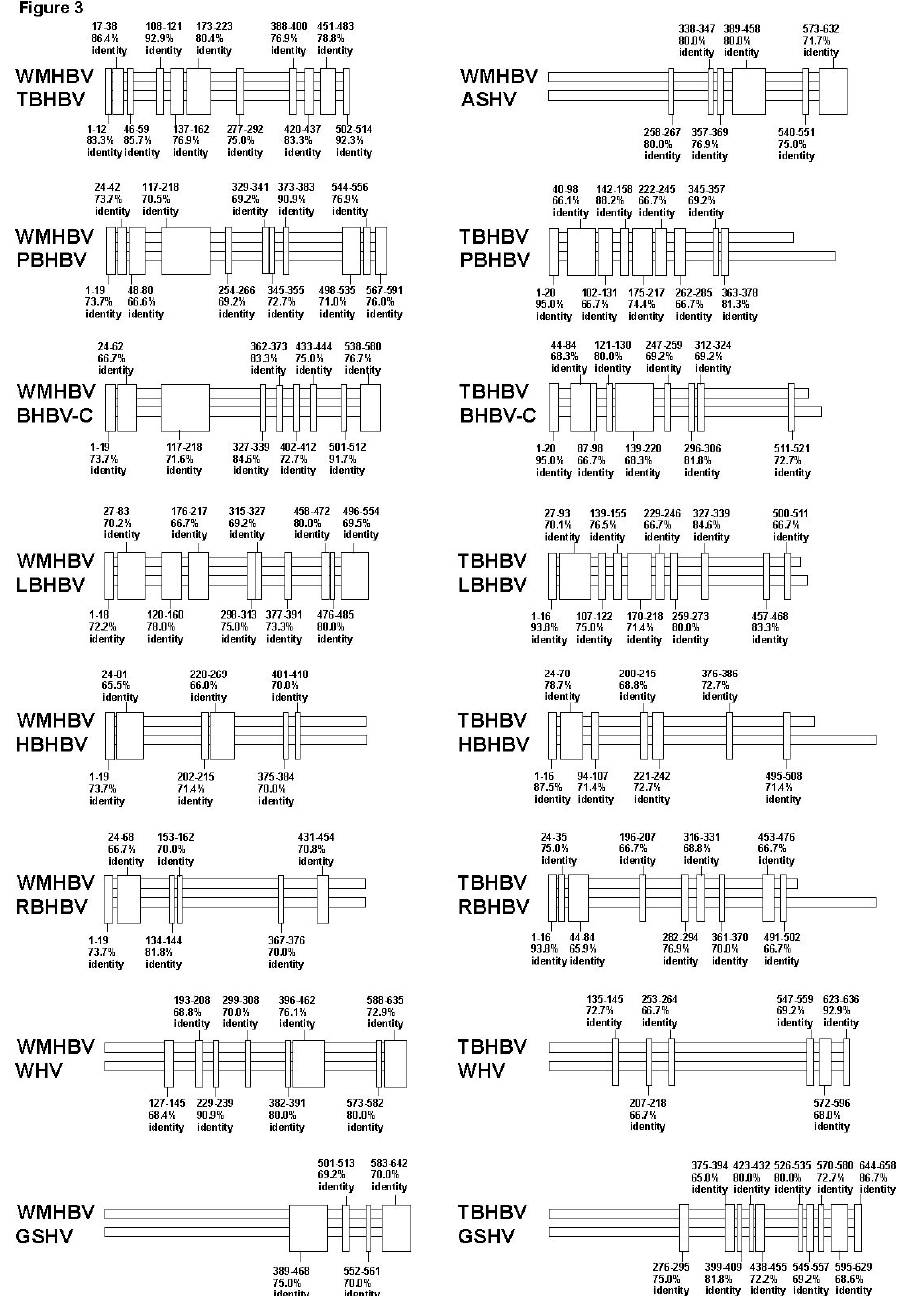
Figure 3. Pair-wise alignments and comparisons of WMHBV, six bat HBVs, and three rodent HBVs in pre-S1 to S2 regions produced 45 patterns, of which the first 16 are shown. (The remaining 29 patterns are shown in Figure S2A,B.) This analysis was performed to clarify partial sequence identity between two species, which may indicate covert conserved genetic segments. Consensus sequence of each species was used for analysis. Maintenance of sequence identity was defined as having approximately 65% identity without gaps and a genetic sequence length ≥ 10 bps without sequence gaps, and segments satisfying these conditions are shown in vertical rectangles. Numbers above or below rectangles show the nucleotide positions where high % identity was observed in pair-wise alignment, and % identity of